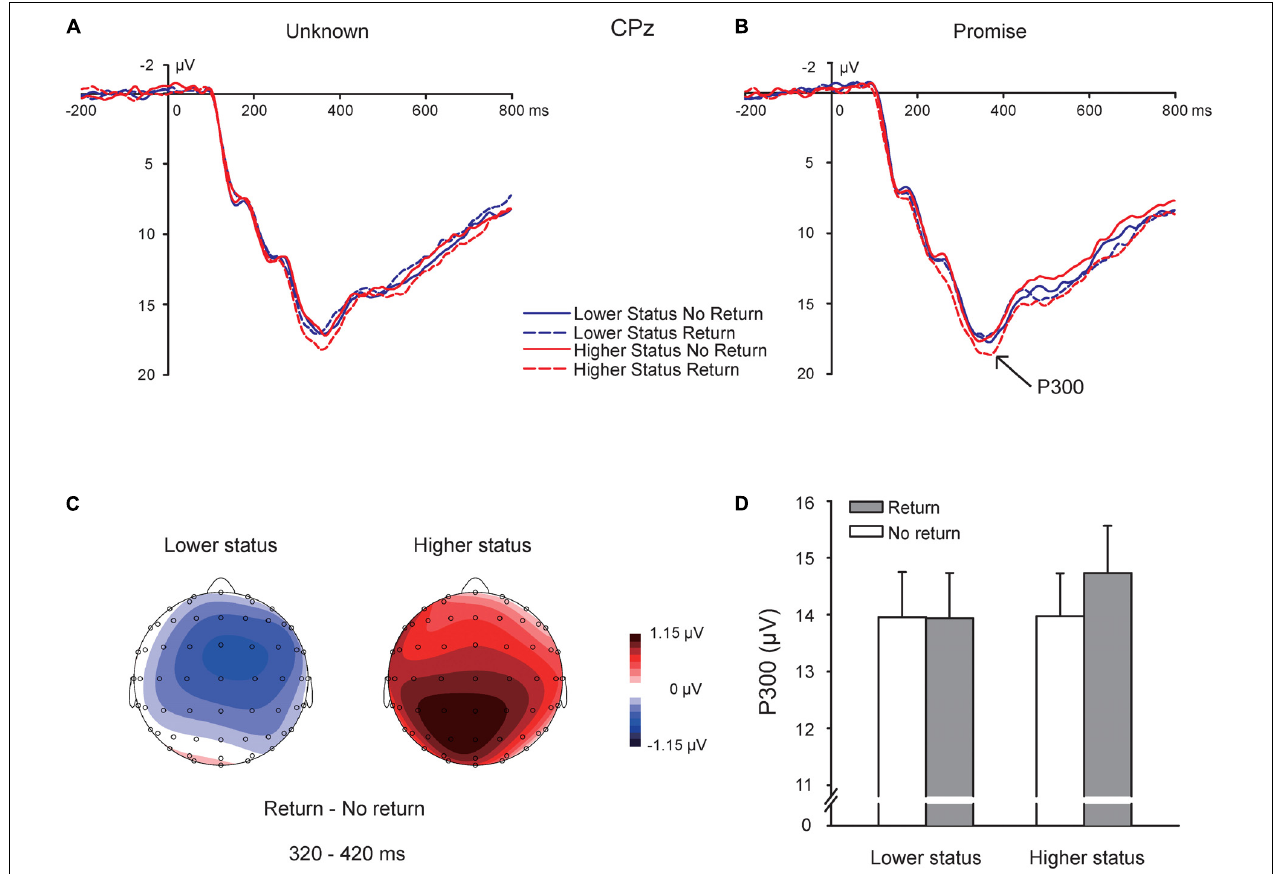
FIGURE 4 | P300. ERP response time-locked to the onset of the TG return feedback at the CPz electrode in the “unknown” (A) and “promise” (B) conditions. Topographic maps for the P300 effect in the 320–420 ms time window (C) . Bar plot depicting the whole-brain average peak values for P300 responses to “return” and “no return” feedback for lower status and higher status partners (D)